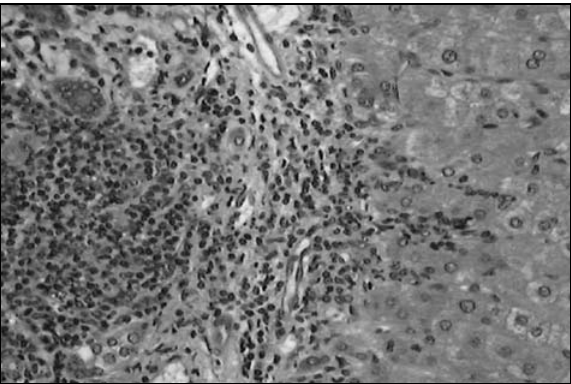
Figura 2 – Infiltração leucocitária mononuclear em um espaço porta ampliado. O infiltrado ultrapassa os limites estroma-parênquima, com coleções de células inflamatórias circunscrevendo grupos de hepatócitos (H & E,